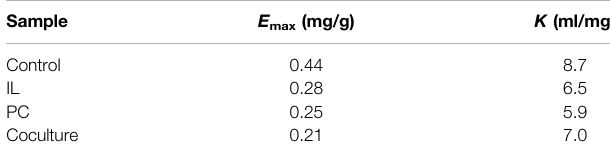
TABLE 4 | Langmuir adsorption isotherm